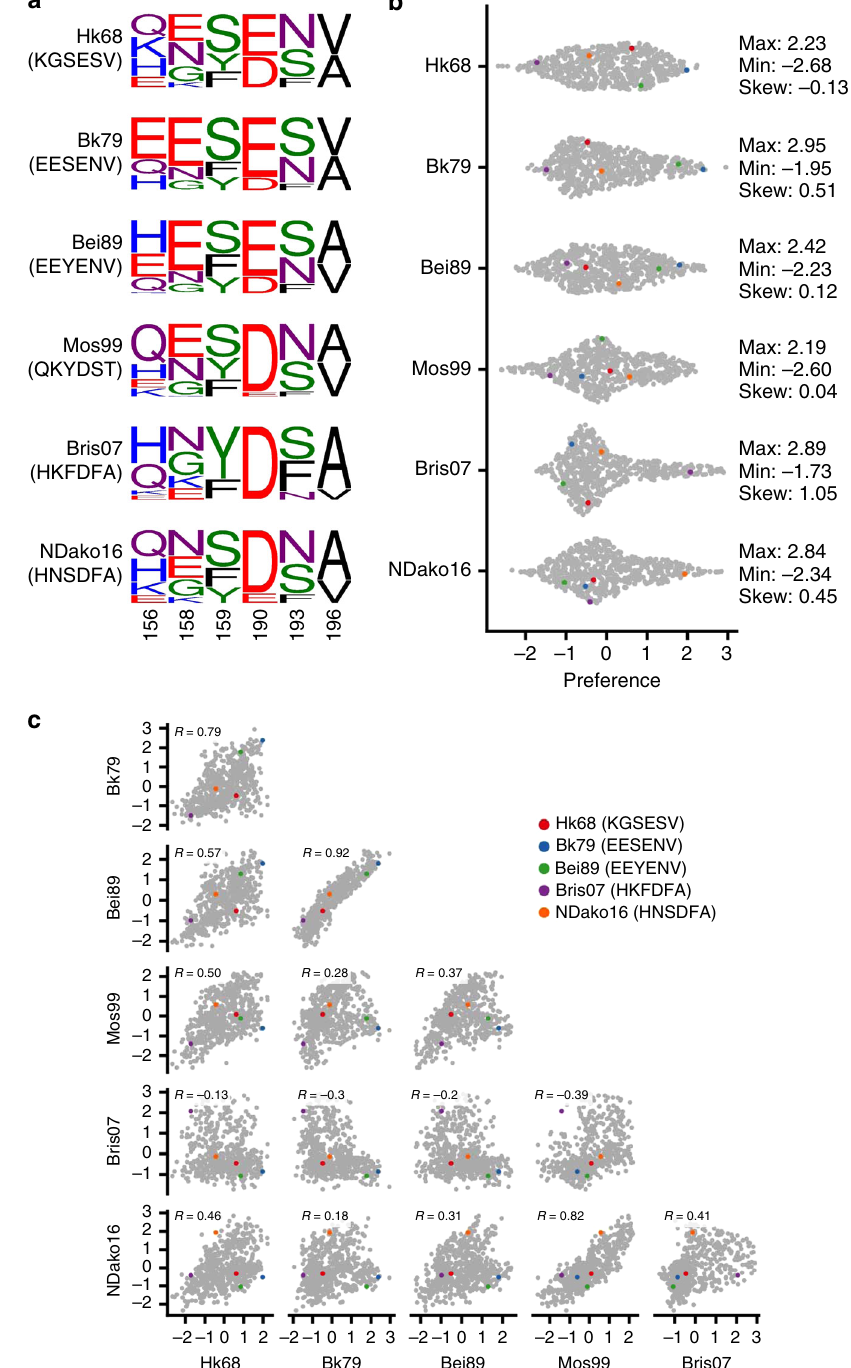
Fig. 2 Comparing the local fi tness landscapes of antigenic site B in six human H3N2 strains. a The fi tness effects of 576 variants, which include all combinations of major, naturally occurring amino acids at residues 156, 158, 159, 190, 193, and 196, are probed by deep mutational scanning. Sequence logo represents the amino acid preferences at each site (from left to right: residues 156, 158, 159, 190, 193, 196). b The distributions of preference for individual variants in different genetic backgrounds are shown as a sina plot, which allows normalized density of points to restrict the jitter along the y -axis. Each data point represents one variant. A total of 576 data points are present for each row (each genetic background). The maximum value (max), minimum value (min), and skewness (skew) for each distribution are indicated on the right. Negative skewness indicates that the mean is less than the median, whereas positive skewness indicates that the mean is larger than the median. Variant preference is the normalized fi tness with a mean of 0 and a standard deviation of 1. c Correlations between the 576 variant fi tness landscapes of different genetic backgrounds are shown, with each data point representing one variant. Pearson correlation coef fi cients ( R ) were computed using the log preferences for the 576 variants. b , c Data points corresponding to the WT sequences of HK68, Bk79, Bei89, Bris07, and NDako16 are colored as indicated. Of note, the WT sequence of Mos99 contains a naturally rare variant T196. Therefore, the WT sequence of Mos99 was not included in our deep mutational scanning